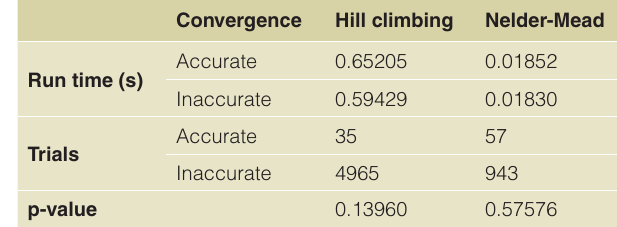
Table 6. Summary of statistical tests on the Rastrigin function minimization results comparing the accuracies associated with each search algorithm.